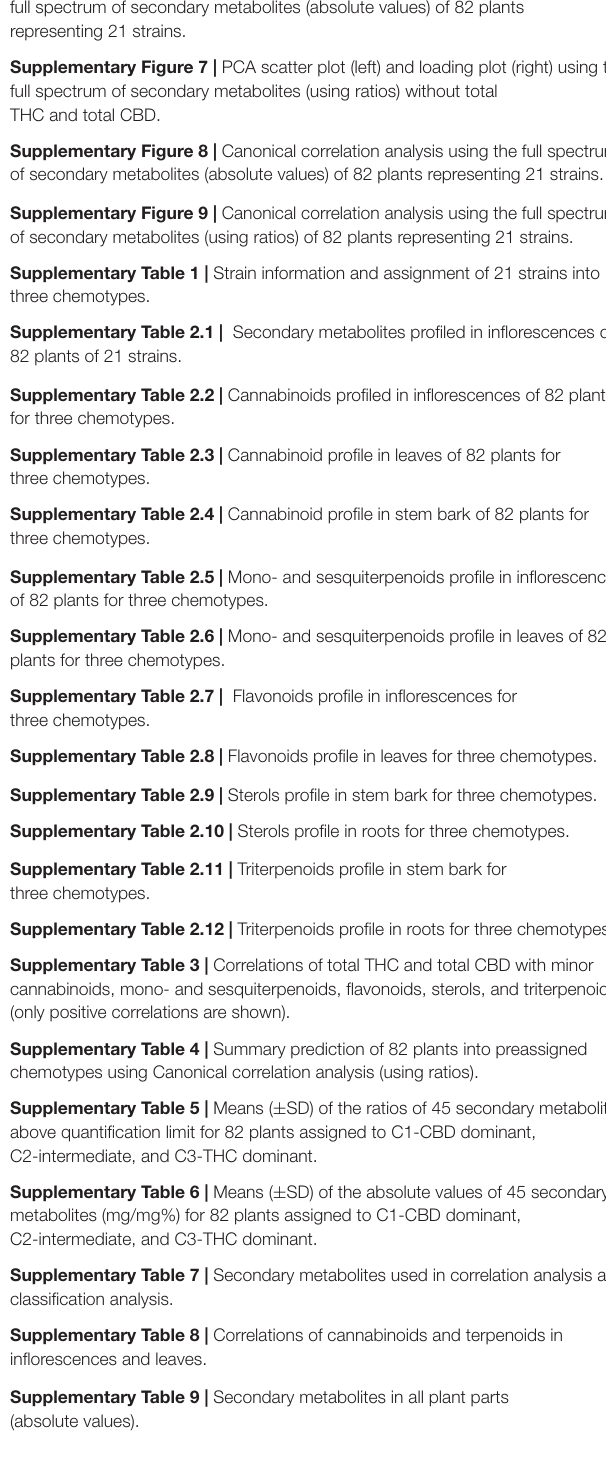
Supplementary Table 7 | Secondary metabolites used in correlation analysis and classification analysis. Supplementary Table 8 | Correlations of cannabinoids and terpenoids in inflorescences and leaves. Supplementary Table 9 | Secondary metabolites in all plant parts (absolute